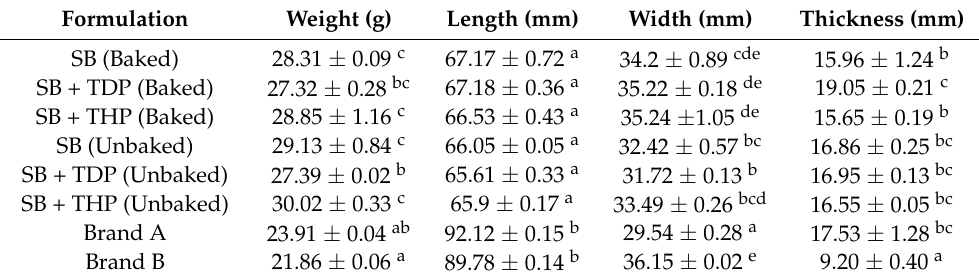
Table 2. Effect of different substitution of tilapia by-product powder on physical quality of snack bars. Formulation